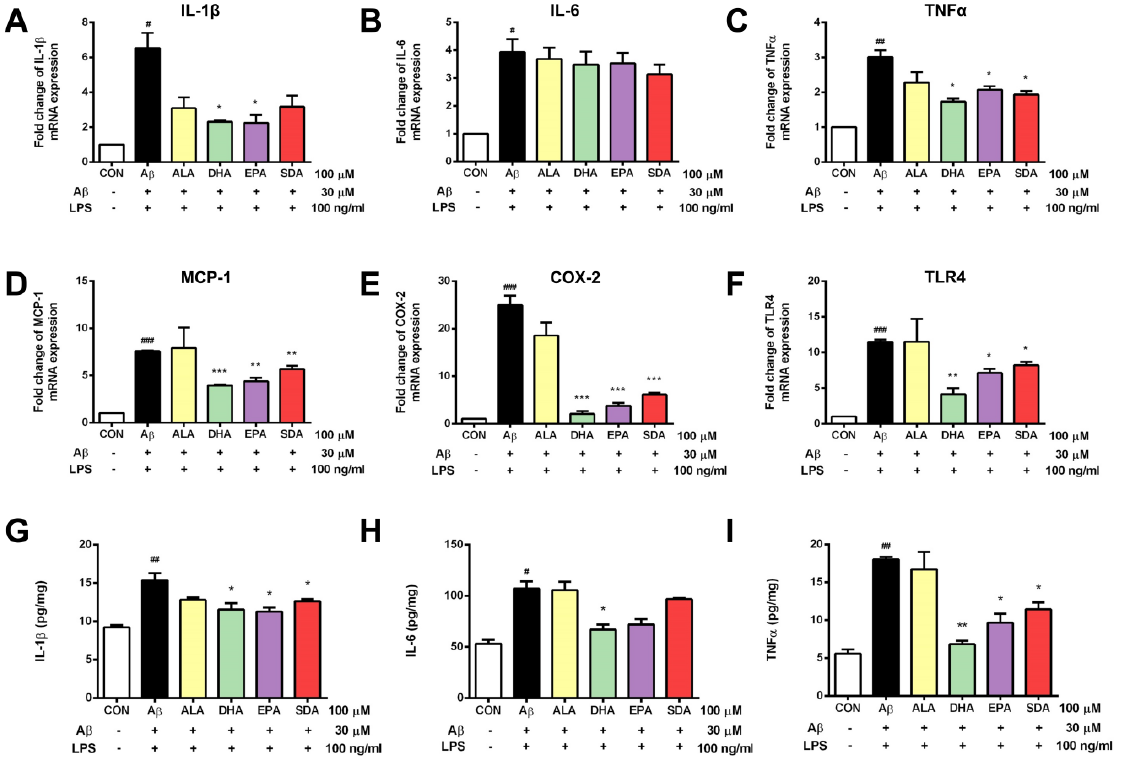
Figure 5. SDA protects against A β -induced inflammation in rat hippocampal cells. H19-7 cells were pretreated with ALA, DHA, EPA, SDA, or BSA–ethanol vehicle control in the concentration of 100 µ M for 48 h, then 30 µ M A β 1-40 and 100 ng/mL LPS were added into the medium for another 24 h incubation. The release of pro-inflammatory cytokines ( A ) IL-1 β , ( B ) IL-6, and ( C ) TNF α and the mRNA expression of proinflammatory mediators ( D ) IL-1 β , ( E ) IL-6, ( F ) TNF α , ( G ) MCP-1, ( H ) COX-2, and ( I ) TLR4 in H19-7 cells induced by A β 1-40 and LPS. Values were obtained from three independent experiments and were expressed as the means ± SEM. # p < 0.05, ## p < 0.01, ### p < 0.001, different from BSA–ethanol vehicle-treated control cells; * p < 0.05, ** p < 0.01, *** p < 0.001, different from A β - and LPS-treated cells.